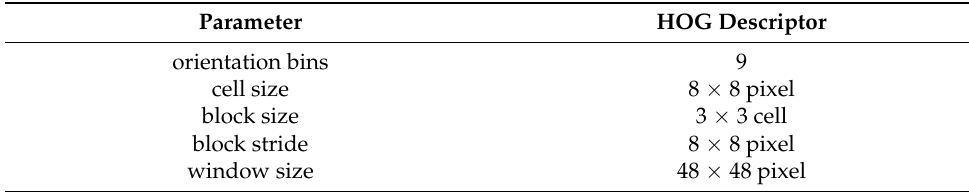
Table 3. Parameter settings of HOG descriptor.